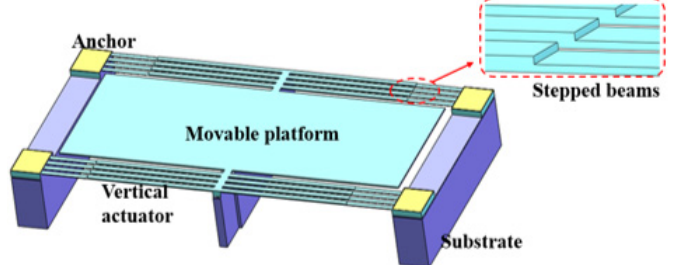
Figure 14. An electrothermal actuator with stepped beams (Kim 2013 [136]).